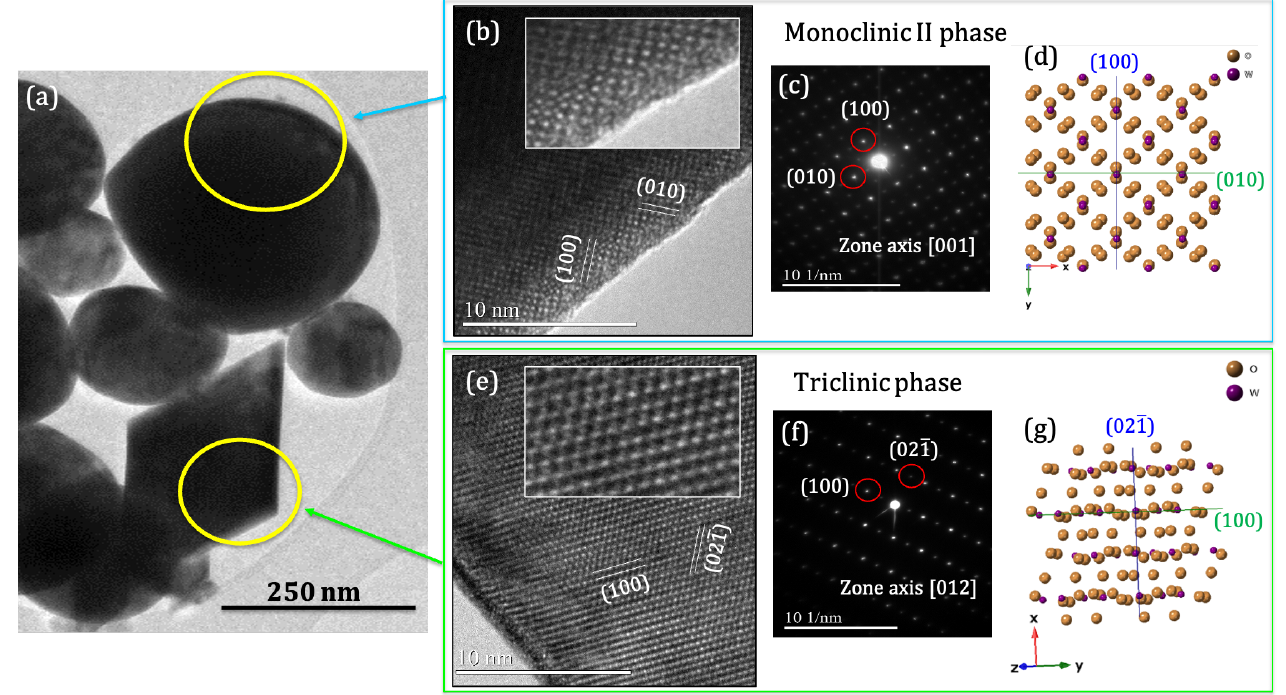
Figure 5. ( a ) TEM image of the obtained nanostructures on the copper electrodes. ( b,e ) HRTEM images. ( c,f ) SAED patterns with labelled diffracting planes according to [001] and [012] axis of the (cid:101) - and δ -phases, respectively. ( d,g ) Atomic arrangement of both crystalline structures according to the SAED